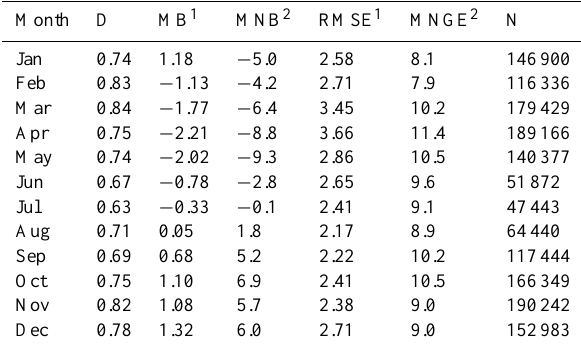
Fig. 12. Comparison of the vertical profiles of CO mixing ratios retrieved by MOPITT and simulated by WRF-Chem during the winter, spring, summer and autumn seasons 2008. WRF-Chem profiles are transformed using MOPITT averaging kernel and a priori profile before this comparison. The vertical profiles are obtained using co-located WRF-Chem and MOPITT data. The difference between WRF-Chem simulated and MOPITT-retrieved average CO value (ppbv) is also shown for each level. Table 3. Seasonal variation in index of agreement (d), mean bias (MB), mean normalized bias (MNB), root-mean-square error (RMSE) and mean normalized gross error (MNGE) computed using the co-located WRF-Chem and MOPITT-retrieved total CO column values. The total number of data points (N) used in the calculation is also